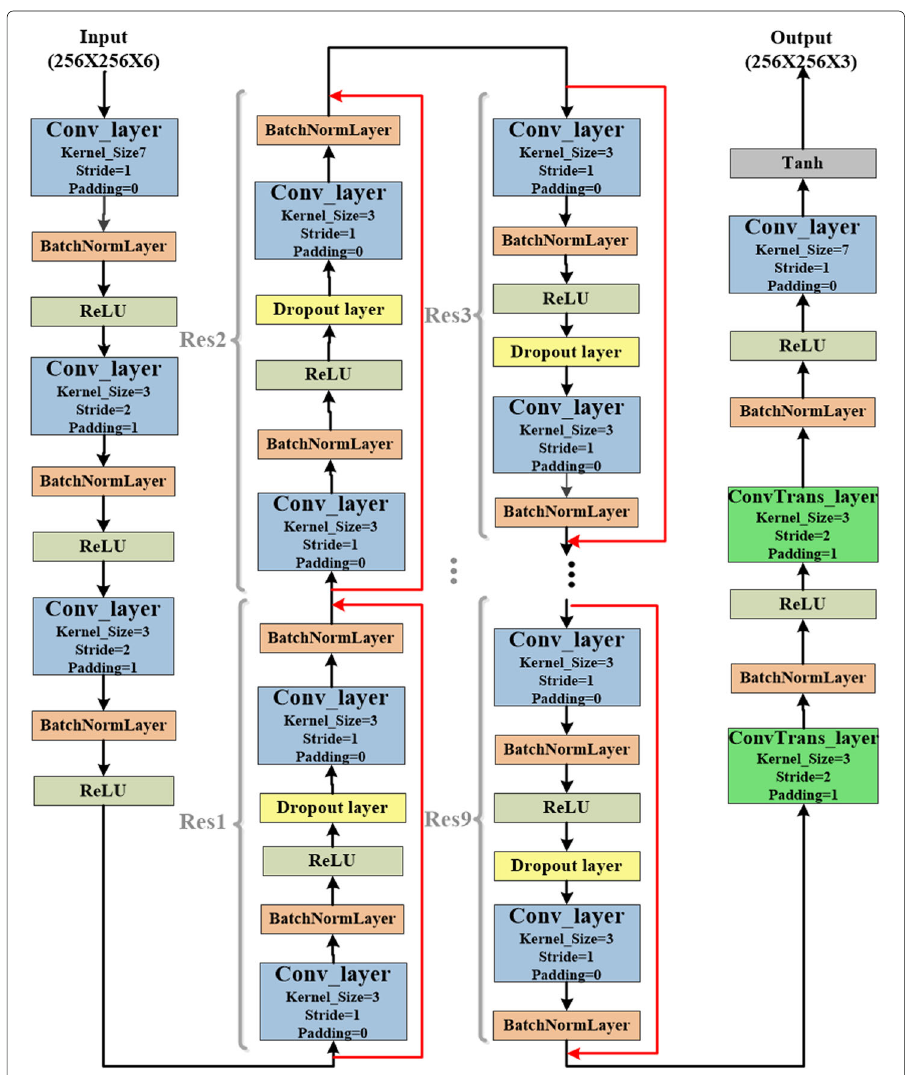
Fig. 2 The structure of encoder network The entire work is composed of three blocks: three downsampling layers, nine residual layers, and three upsampling layers. In the downsampling phase, the channels of image gradually increase from 6 to 256. In the residual layers, the channels and size of feature maps are maintained at 256 and 64. In the upsampling layers, the channels of feature maps gradually reduce from 256 to 3